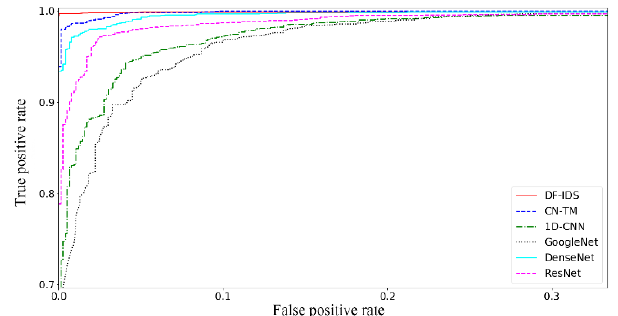
Figure 8. Comparison of ROC curves.